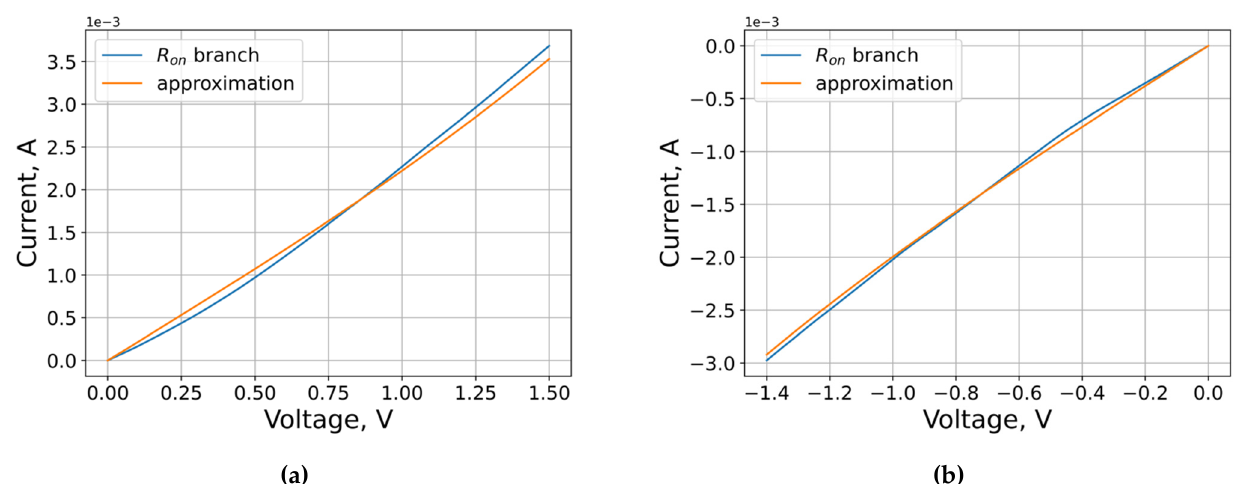
Figure 3. The results of the low-resistance branch approximation: (a) positive voltages; (b) negative voltages.